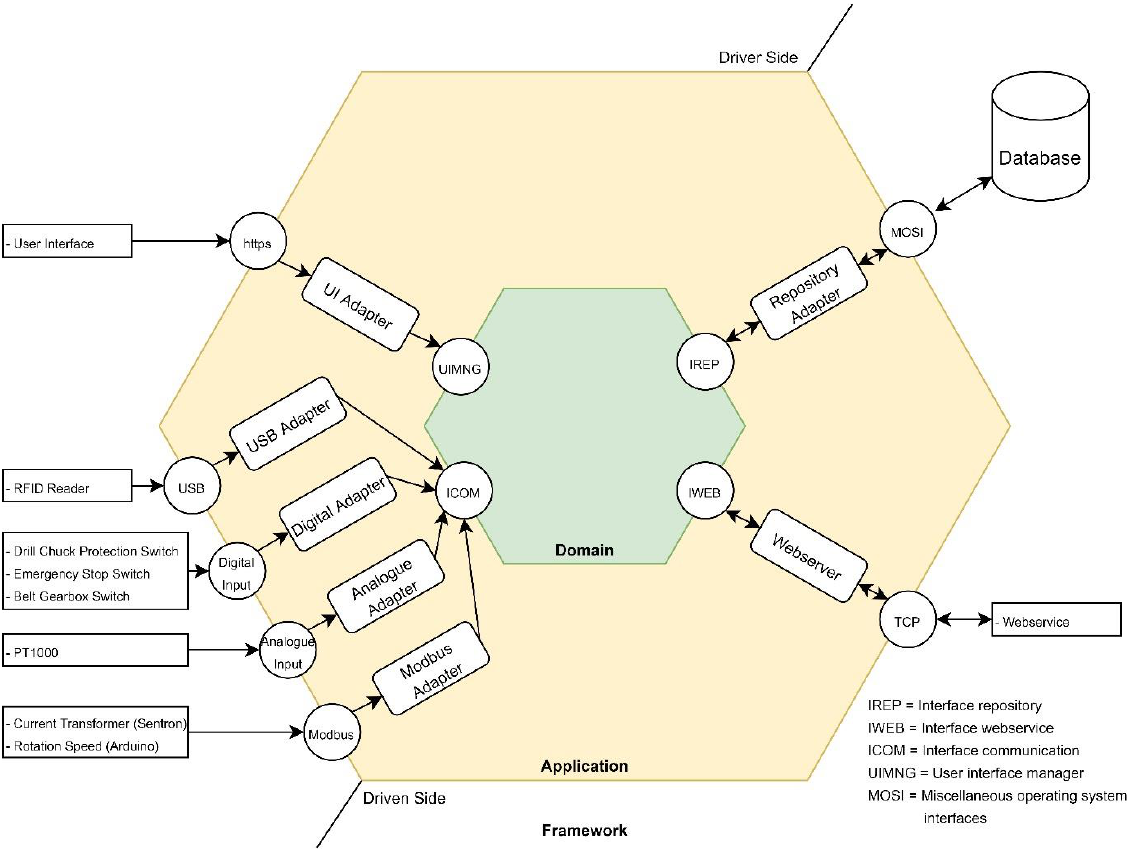
Figure 1. Software